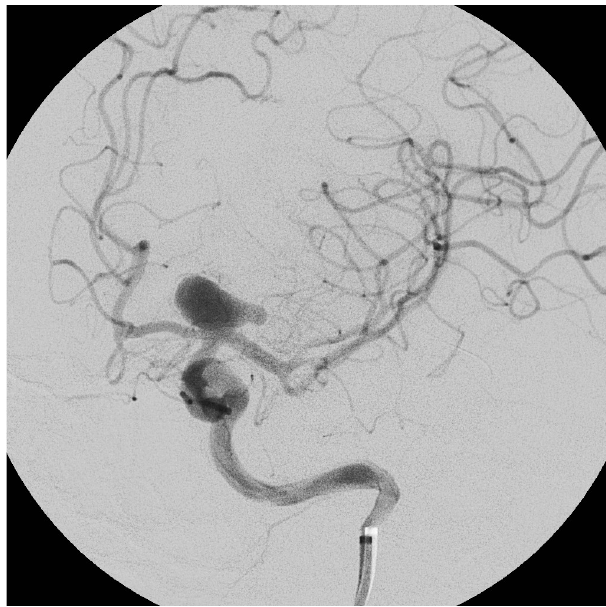
Figure 1. Cerebral angiography demonstrated a wide necked aneurysm at the termination of the ICA.